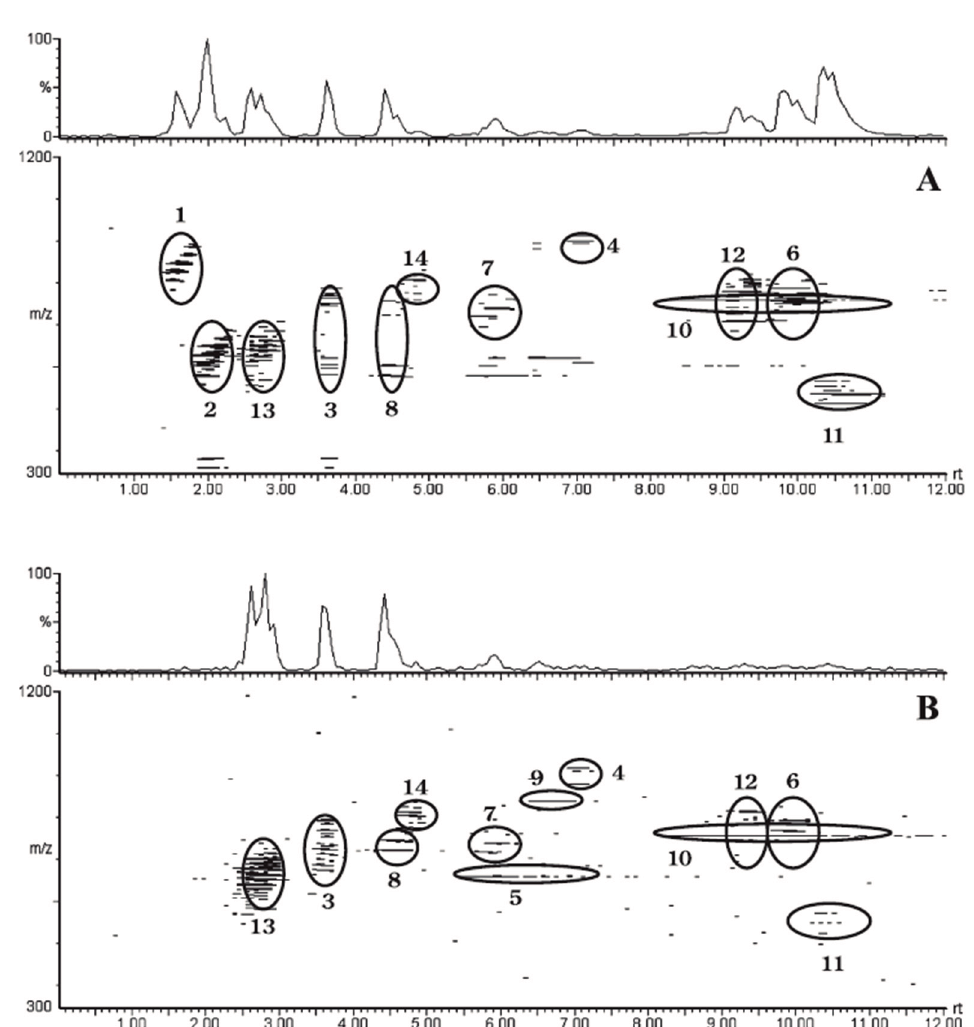
Figure 6. Base peak ion (BPI) chromatograms and 2-D displays of SFC-MS data obtained from the lipid mixtures by using a cyano column in the positive-ion mode ( A ) and negative-ion mode ( B ). 1. triglyecrides; 2.diglycerides; 3.monoacylglycerol; 4.diglyceride dimers; 5. phosphatidic acids; 6. phosphatidylcholines; 7. phosphatidylethanolamines; 8. phosphatidylglycerols; 9. 10. 11. lyso-phosphatidylcholines; 12. sphingomyelins; 13.cermaides; and 14.cerebrosides [16], with